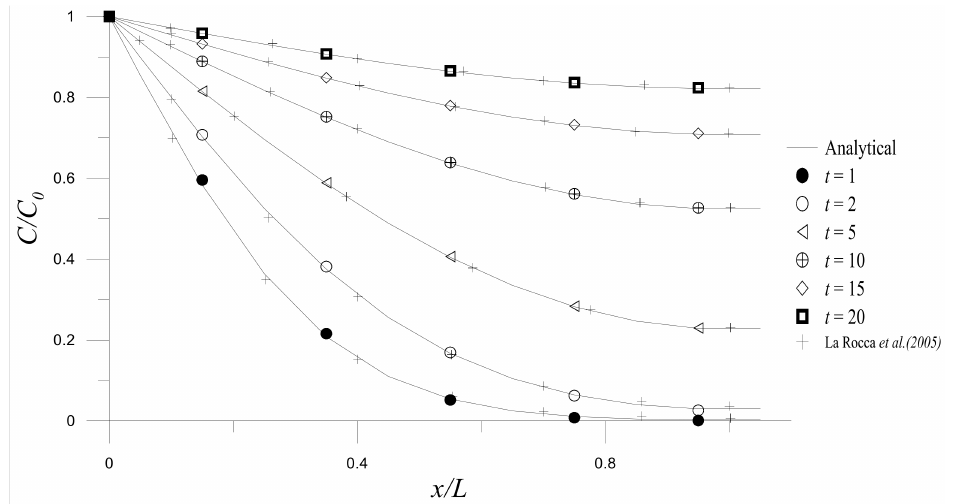
Figure 2. Comparisons between the numerical results of Hermite MAPS, the analytical solutions and the results in the literature for Example